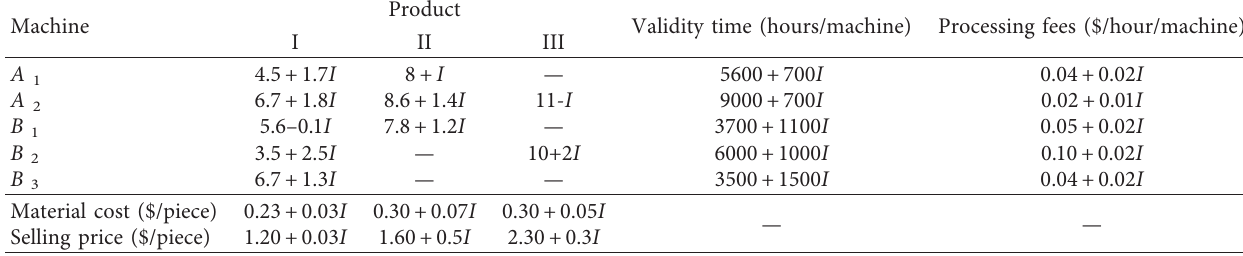
Table 1: All data of three types of